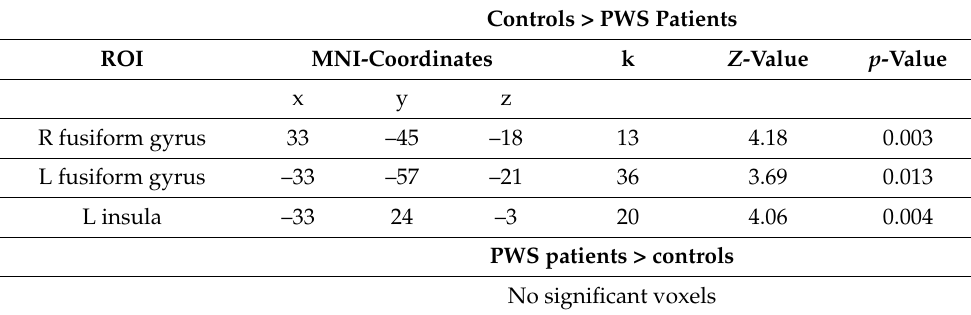
Table 3. Interaction effects of watching food versus non-food